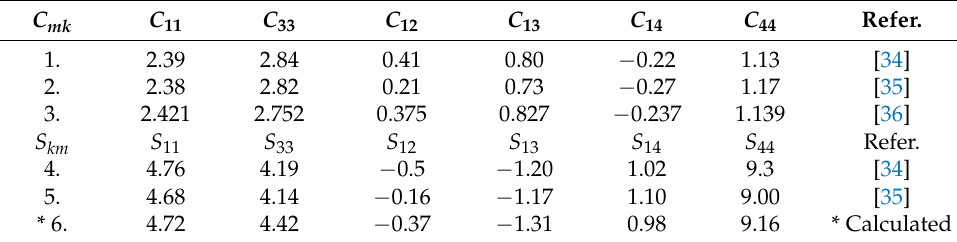
Table 2. Elastic stiffness coefficients C mk (in 10 11 N/m 2 ) and elastic compliance coefficients S km (in 10 − 12 m 2 /N) of LiTaO 3